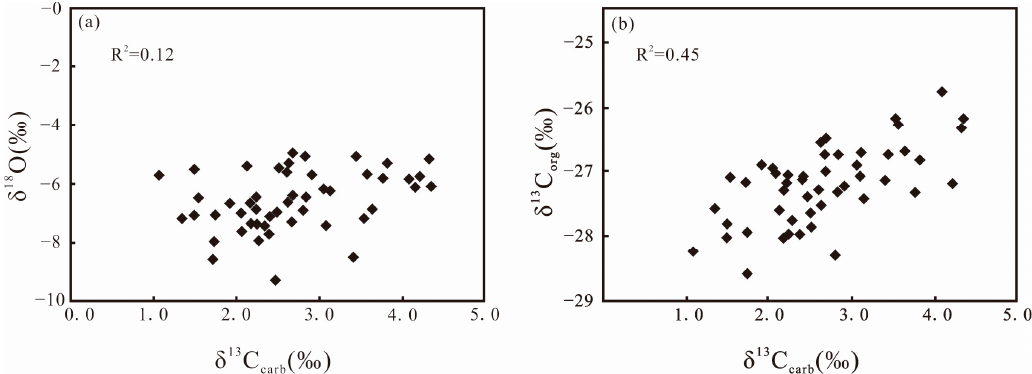
Figure 5. Cross-plots between ( a ) δ 13 C carb vs. δ 18 O and ( b ) δ 13 C carb vs. δ 13 C org of the Putaoling section, Chaohu.